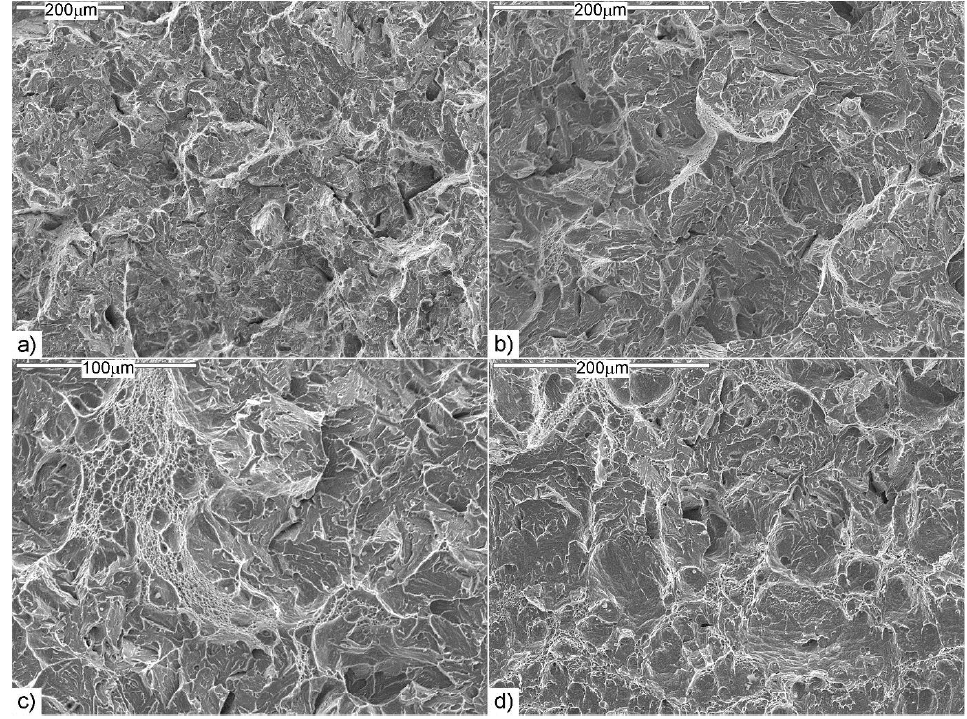
Figure 15. Fracture of the tested sample austenitized at 1100 °C: ( a ) the quasi-brittle central zone with visible ductile area; ( b ) the central zone with visible “small column” and cleavable zones; ( c ) the ductile band in the central zone; ( d ) plastic zone in the lower part of the sample (opposite to the mechanical notch), SEM.